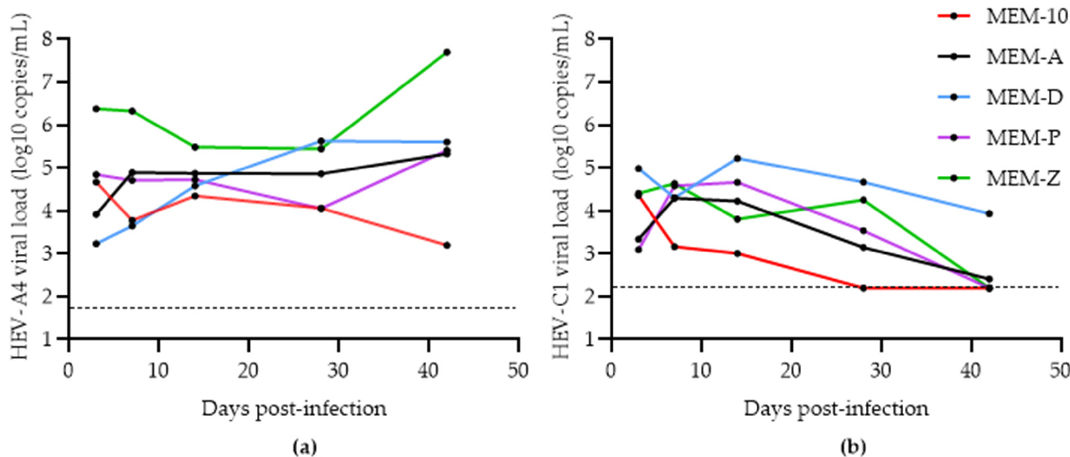
Figure 5. Growth of hepatitis E virus (HEV) in PLC/PRF/5 cells maintained in MEM-10, MEM-A, MEM-D, MEM-P, and MEM-Z for ( a ) HEV-A genotype 4 (HEV-A4) and ( b ) HEV-C genotype 1 (HEV-C1) variants. Each data point represents the mean of two replicates. Limit of detection of the RT-qPCR assay is represented by the dashed line (50 and 160 copies per mL for HEV-A4 and HEV-C1, respectively).